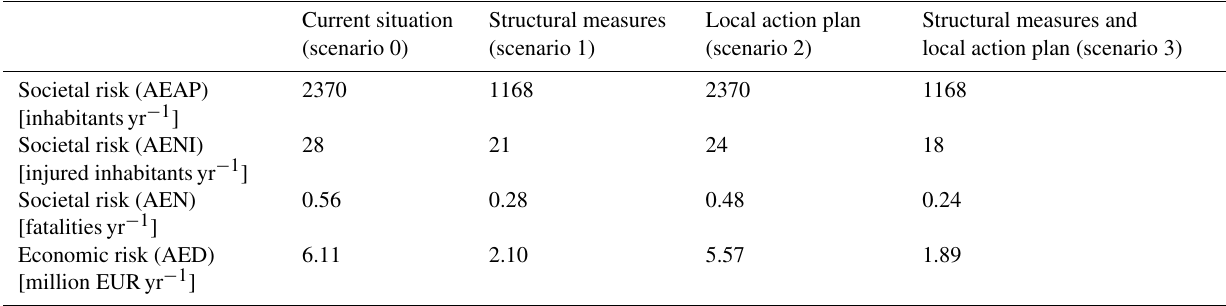
Table 6. Results from risk model per scenarios CS, BC, and effect of local action